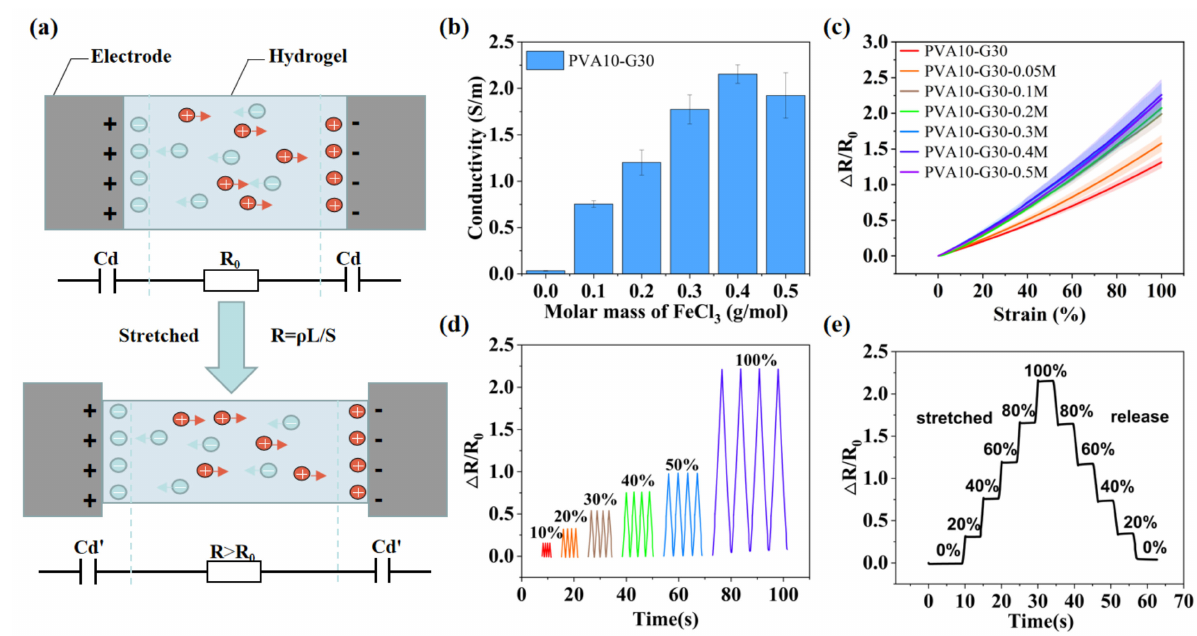
Figure 6. ( a ) Schematic diagram of the working principle of the IHSS. The electrical double layer (EDL) forms at the electrode and electrolyte interface. The EDL behaves like a capacitor and is considered a constant to simplify the model. ( b ) The conductivity of PVA-G-FeCl 3 hydrogels with different ion concentrations. The critical point concentration is about 0.4 M. ( c ) Comparison of relative resistance change of PVA-G-FeCl 3 hydrogels with ion concentration from 0 M to 0.5 M. The